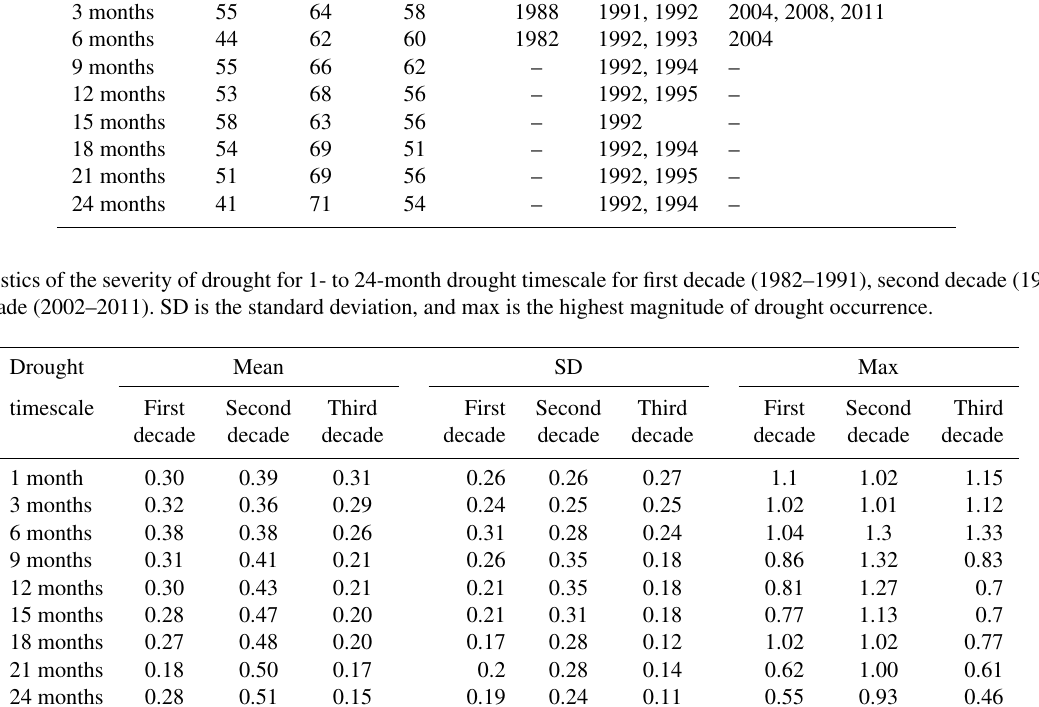
Table 2. Characteristics of drought occurrence for a 1- to 24-month drought timescale for the first decade (1982–1991), second decade (1992– 2001), and third decade (2002–2011).